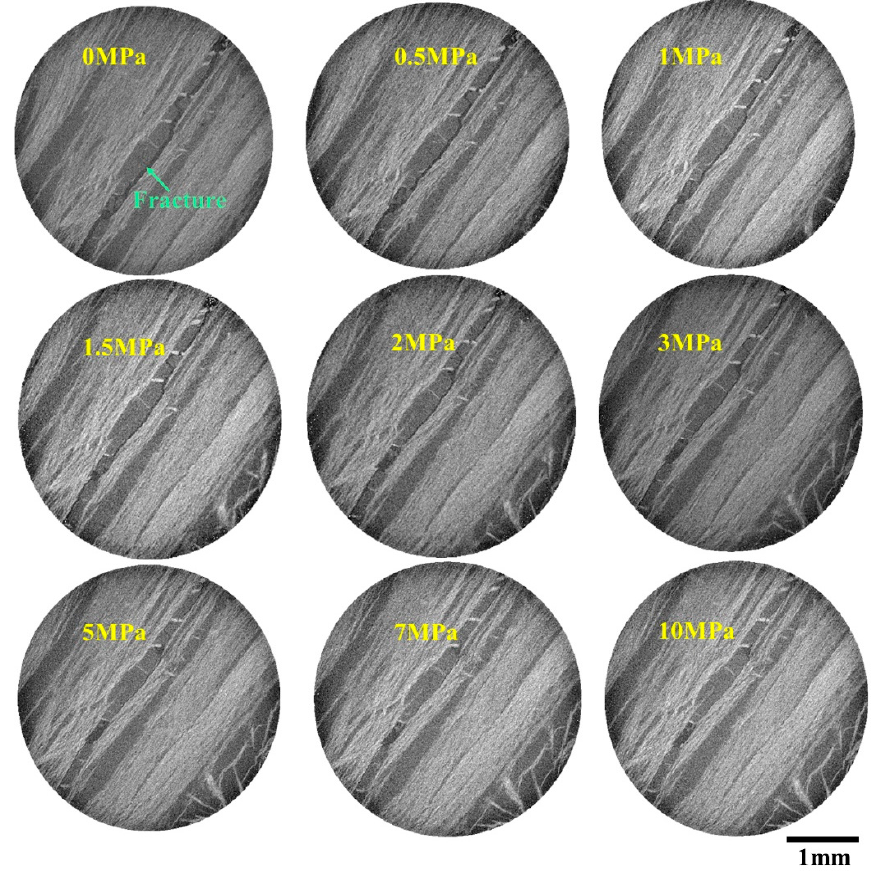
Figure 5. The 2D images of the same position in the first cycle (with the increase in confining pressure).